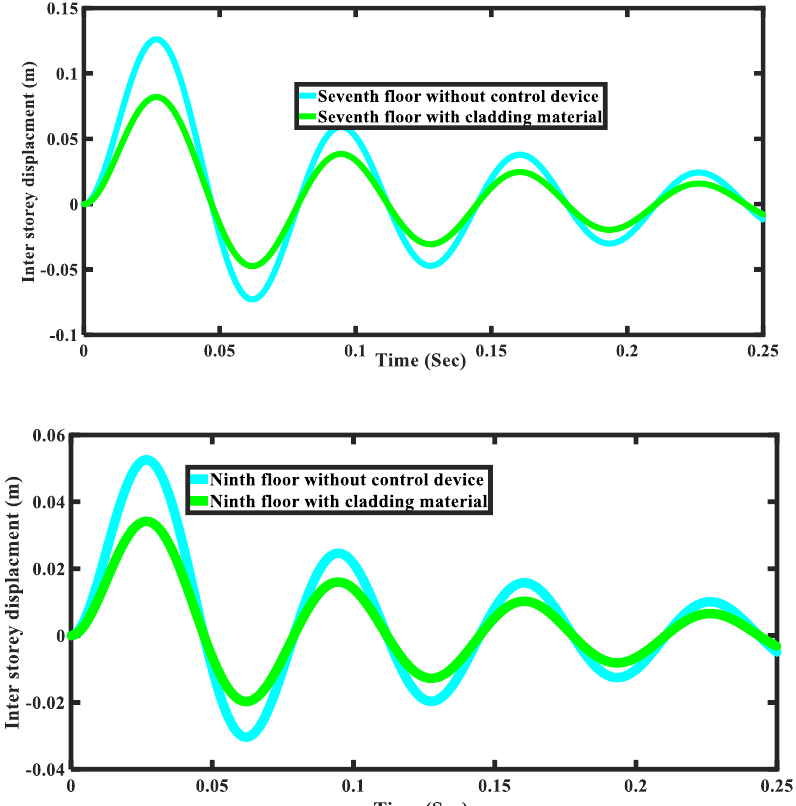
Fig. 11. Reduction of inter storey displacement of seventh and ninth floor by cladding material Fig. 11 shows the reduction of inter storey displacement at seventh and ninth floor by using cladding material. Fig. 12 shows the pressure impulse curve of first and sixth floor. By using cladding material for 0.1 to 0.2 kpa of pressure at first floor and 0.002 to 0.006 kPa of pressure at sixth floor cannot cause damage to the structure. From the pressure impulse curve, the structure is safe from the curve falls below